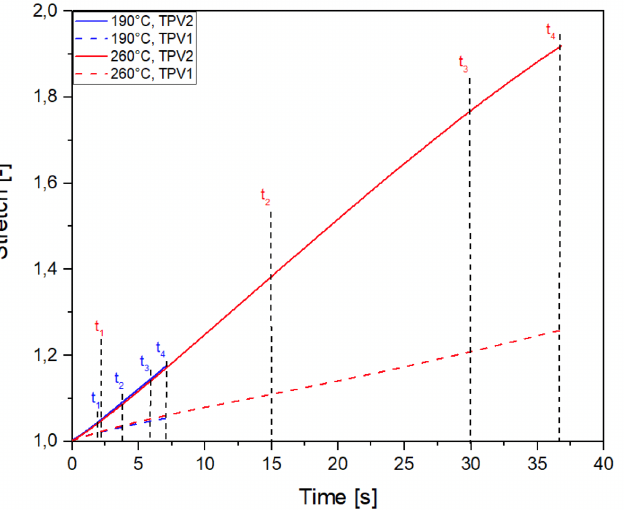
Figure 10. Stretch-time evolution for each TPV overmoulded at 190 ◦ C and 260 ◦ C, in the case of monotonic tensile test until rupture.